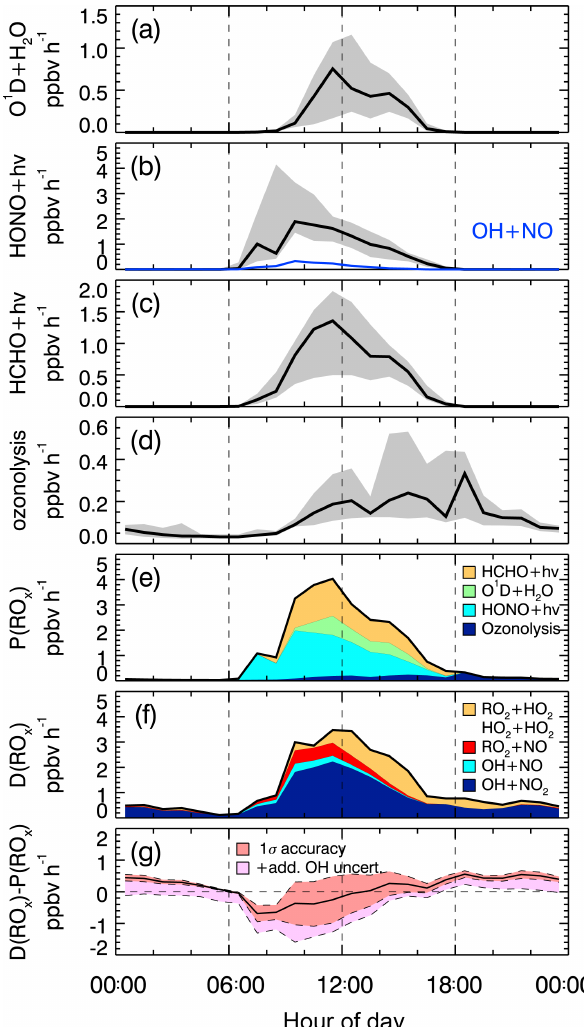
Figure 2. Median production and destruction rates of RO x . (a)– (d) show production rates (black lines: median values) from the photolysis of ozone (a) , HONO (b) , HCHO (c) , and ozonolysis of alkenes (d) . Grey bands around the median denote 25% and 75% percentiles. The blue line in (b) represents the back reaction rate of OH + NO yielding HONO. (e) and (f) show cumulative plots of the production and destruction rates, respectively; (g) the solid black line is the difference between the total production and destruction rate. The red shaded band indicates the 1 σ uncertainty due to exper- imental errors of the measured quantities (Table S1) and the reac- tion rate coefficients. The pink shaded area represents the maximum possible bias from a potential OH